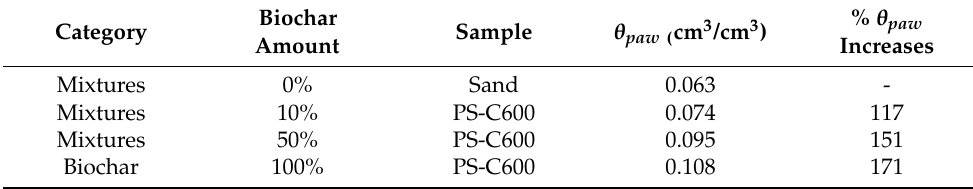
Table 7. Plant available water ( θ paw ) for mixtures of sand and